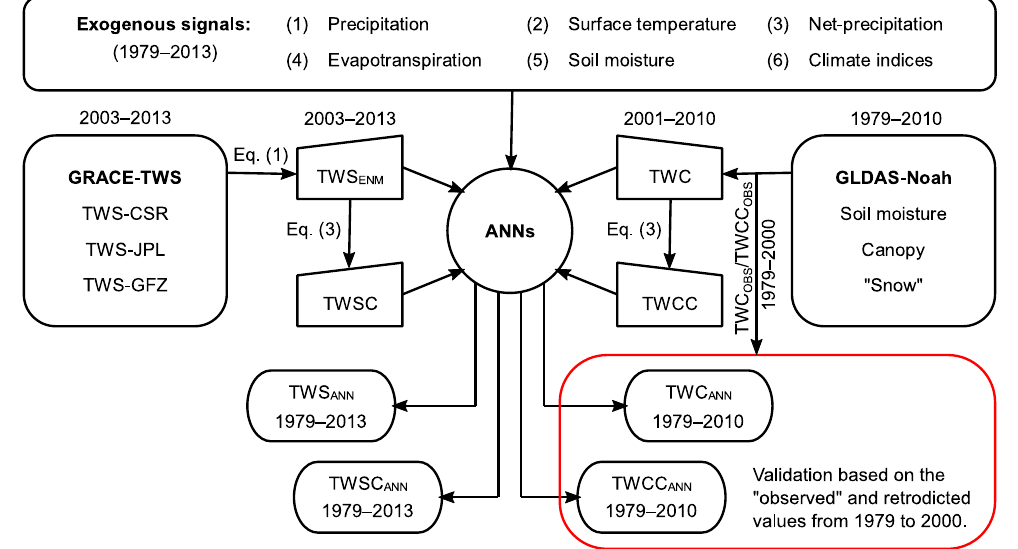
Figure 2. Flowchart describing the main steps to backcast Gravity Recovery and Climate Experiment (GRACE) ‐ derived terrestrial water storage (TWS) and terrestrial water storage changes (TWSC). For